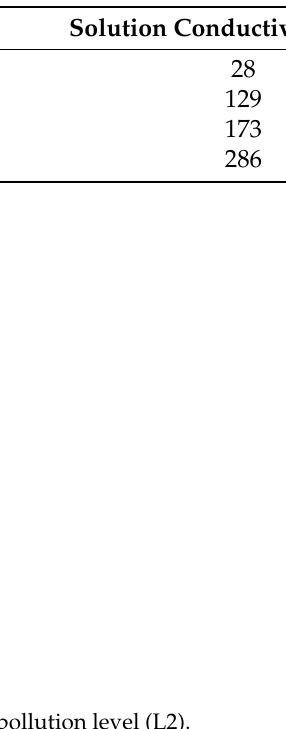
Table 1. Information about salt amount and conductivity of four levels of artificial pollution.